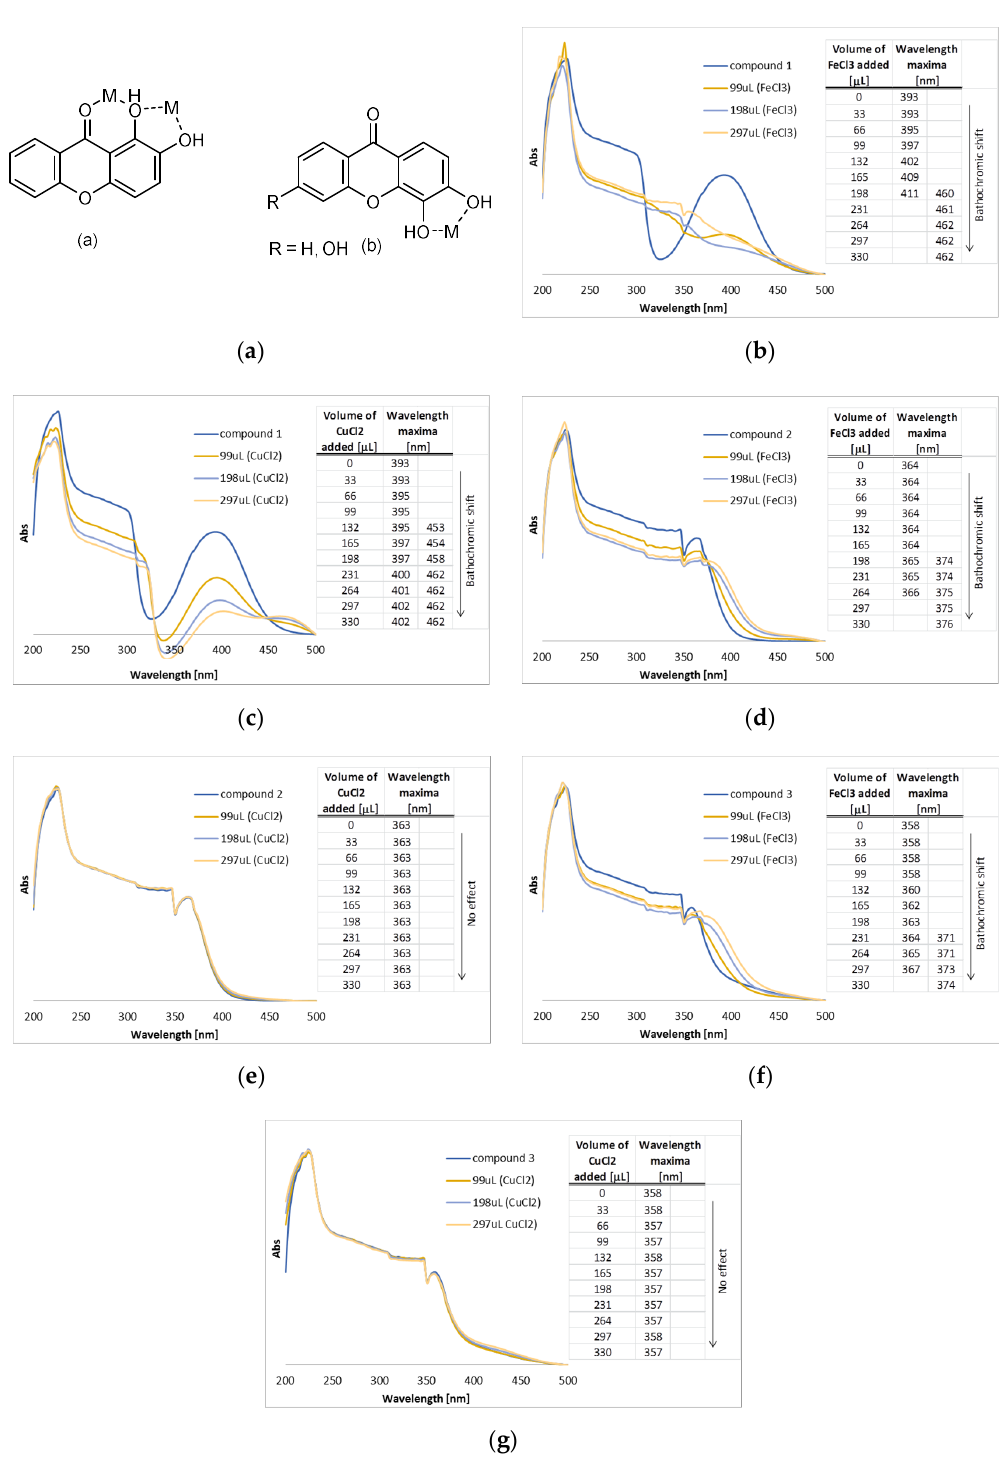
Figure 2. ( a ) Typical metal (M) chelation sites in 1,2-dihydroxy- ( 1 , a) and 3,4-dihydroxyxanthones ( 2 – 3 , b); ( b ) UV/Vis spectra of compound 1 in methanolic solution with sequential additions of FeCl 3; ( c ) UV/Vis spectra of compound 1 in methanolic solution with sequential additions of CuCl 2 ; ( d ) UV/Vis spectra of compound 2 in methanolic solution with sequential additions of FeCl 3 ; ( e ) UV/Vis spectra of compound 2 in methanolic solution with the sequential addition of CuCl 2 ; ( f ) UV/Vis spectra of compound 3 in methanolic solution with sequential additions of FeCl 3 ; ( g ) UV/Vis spectra of compound 3 in methanolic solution with the sequential addition of CuCl 2.